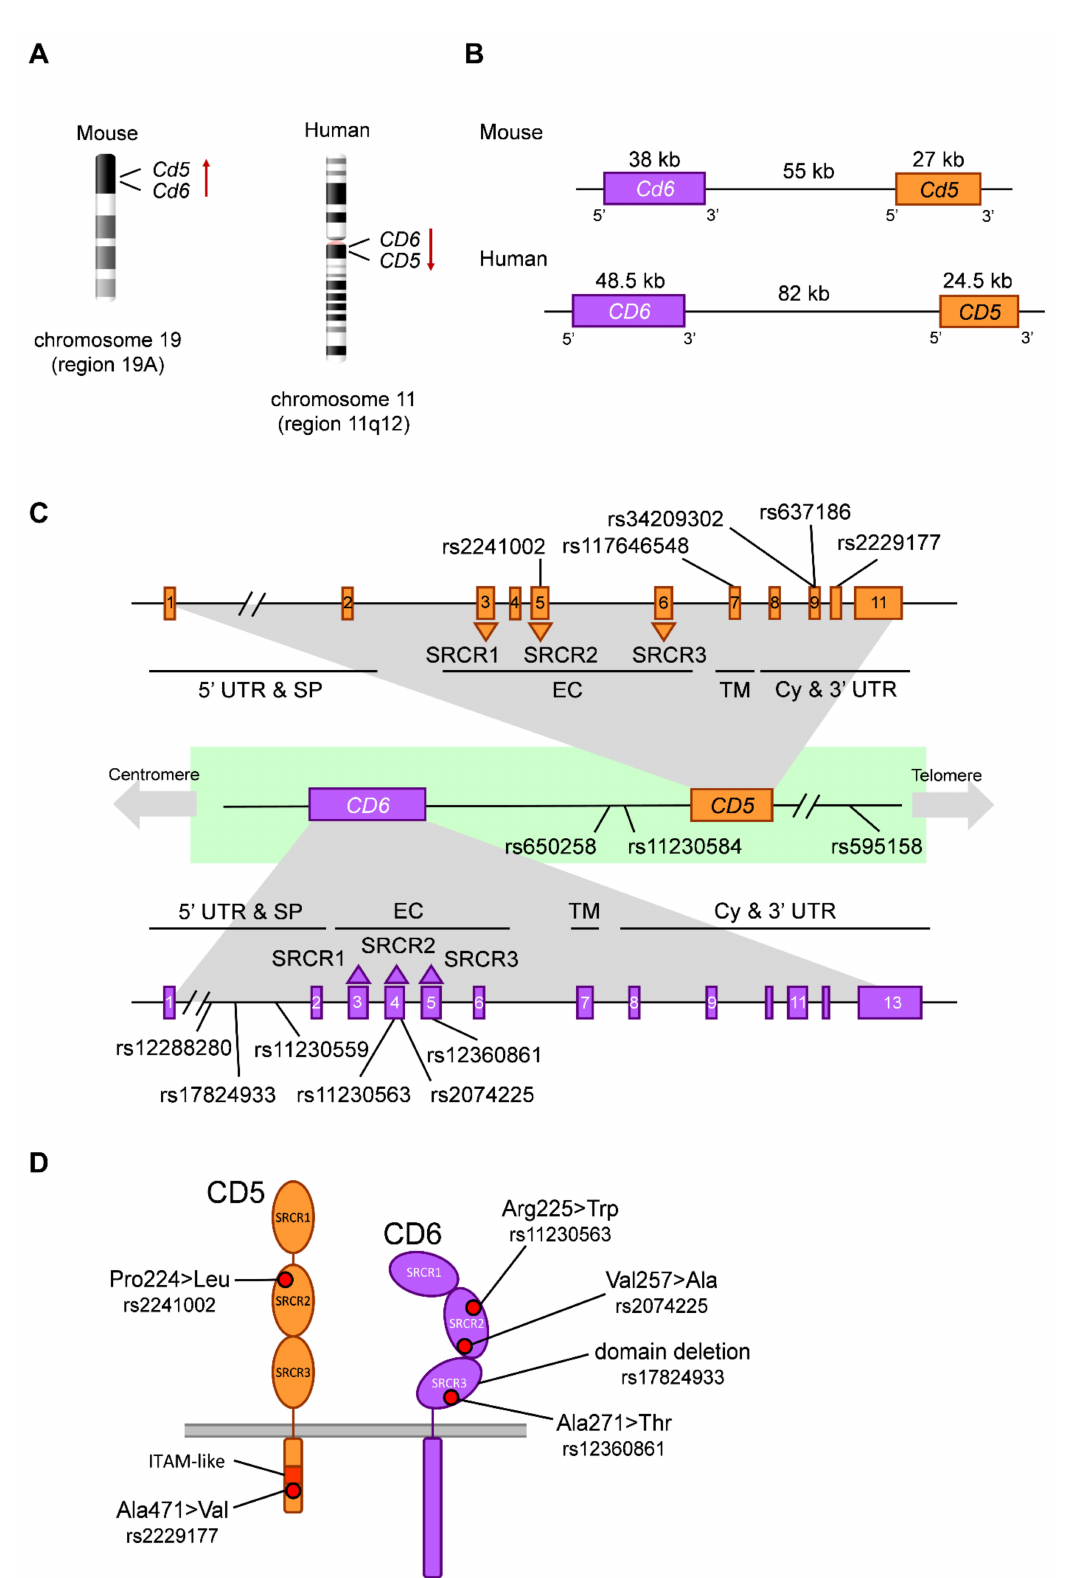
Figure 1. Genomic location and arrangement of CD5 and CD6 . ( A ) Chromosome location of mouse and human genes coding for CD5 and CD6 . Red arrows indicate 5 (cid:48) to 3 (cid:48) orientation. ( B ) Size, orientation and intergenic distance